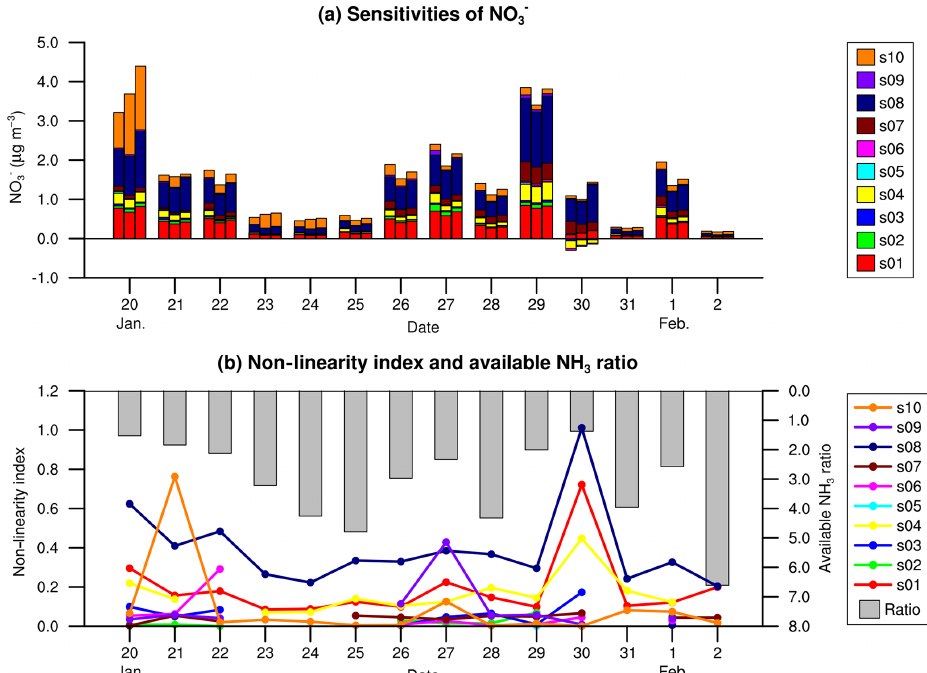
Figure 7. (a) Sensitivities of the daily NO − concentrations to the source groups located within d02 (s01–s10) derived by BFM (left), 3 HDDM-20 (middle), and HDDM-100 (right) and (b) daily non-linearity index and available NH 3 ratios for the 2 target weeks in winter in ST. Non-linearity indices for first-order sensitivity coefficients less than 0.001µgm − 3 are not shown as they are likely to be affected by numerical noise.